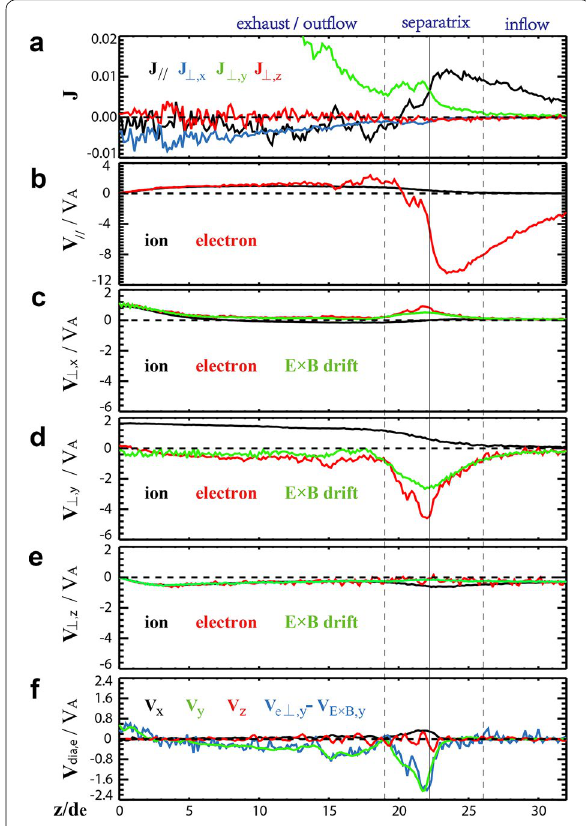
Fig. 3 The decompositions of the current and plasma flows. a The current density. The black curve presents the parallel current density, and blue for x -component of the perpendicular current, green for y -component of the perpendicular current, red for z -component of the perpendicular current. b The parallel bulk velocity for ions ( black ) and electrons ( red ). c – e x -, y -, z -components of the perpendicular bulk velocity for ions ( black ), electrons ( red ), and the E B drift veloc- × ity ( green ). f The electron diamagnetic drift velocity ( black , green , and red for x -, y -, z -components respectively), and y -component of the difference between the perpendicular electron bulk velocity and the E B drift, i.e., δV e V e V E ( green ). The vertical solid × ⊥ , y = ⊥ , y − × B , y line marks the D ng peak, while the two vertical dashed lines mark the